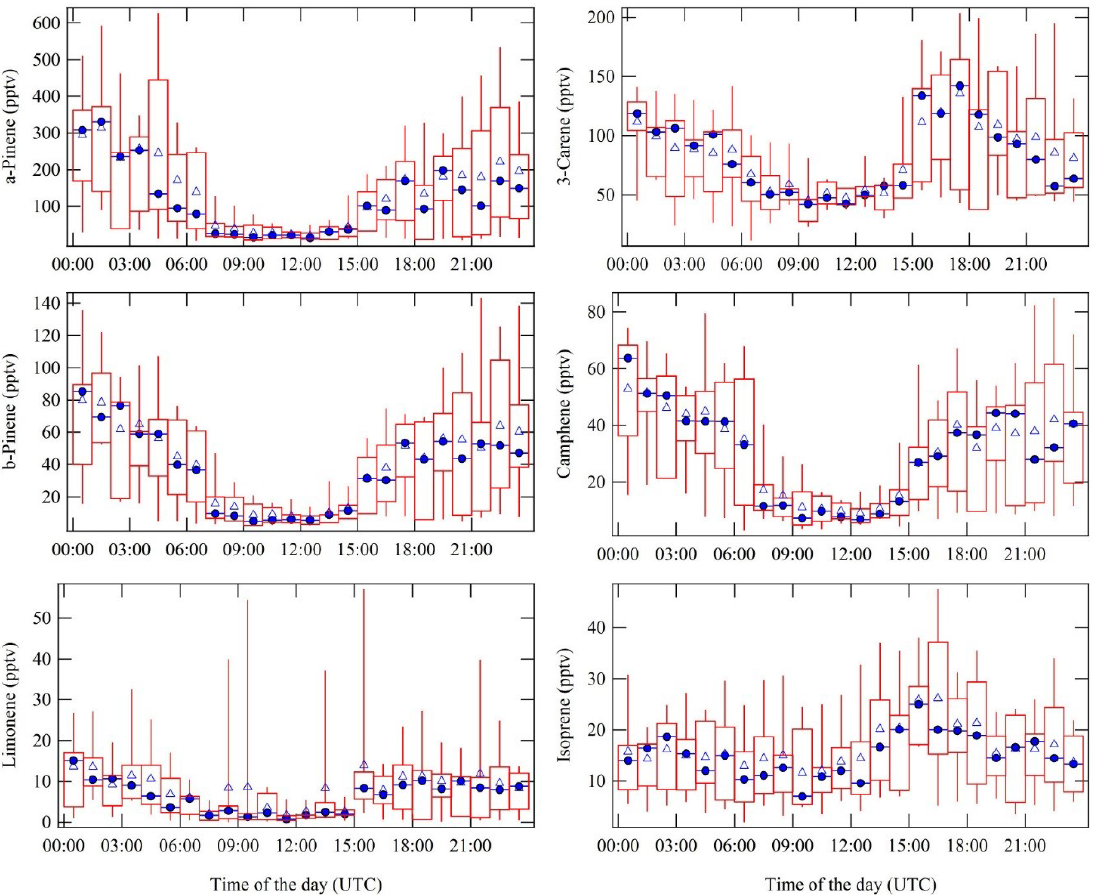
Figure 5. Complete measurement period average diel cycles of α -pinene, (cid:49) -3-carene, β -pinene, camphene, d -limonene, and isoprene. To exclude the nearby sawmill (5km in the southeast direction) monoterpene emission transport event, the data from 9 until 11 September 06:30UTC were not included in the diel cycles. Blue triangles resemble the campaign overall hourly average, and blue circles represent the hourly median values. The red rectangles with the whiskers show the data spread; 50% of the data points fall into the rectangles. The upper whiskers signify the upper 75th percentile data spread, and the lower whiskers indicate the lower 25th percentile of the data variation. Substantially higher MRs were observed at nighttime compared to